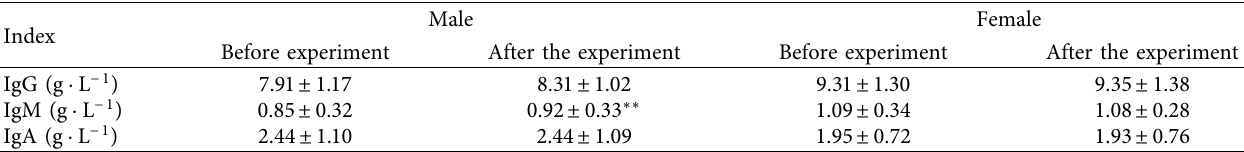
Table 4: The results of changes in the immune indexes of athletes.